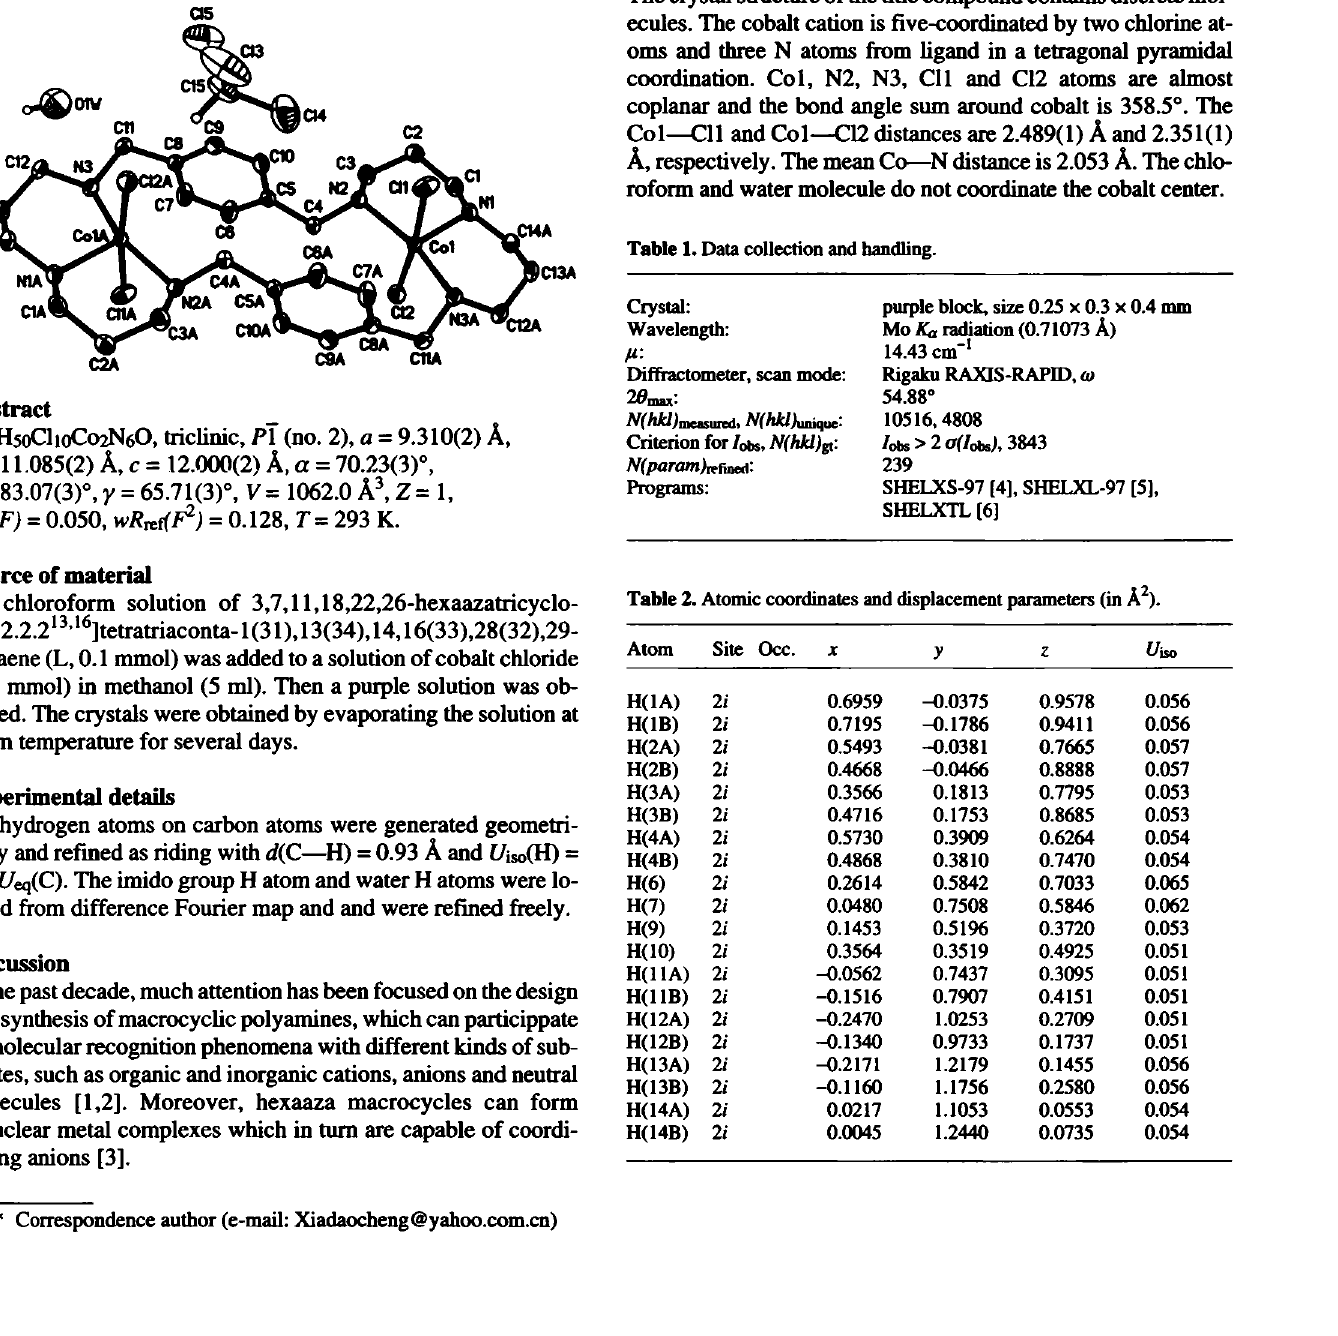
Table 2. Atomic coordinates and displacement parameters (in À 2